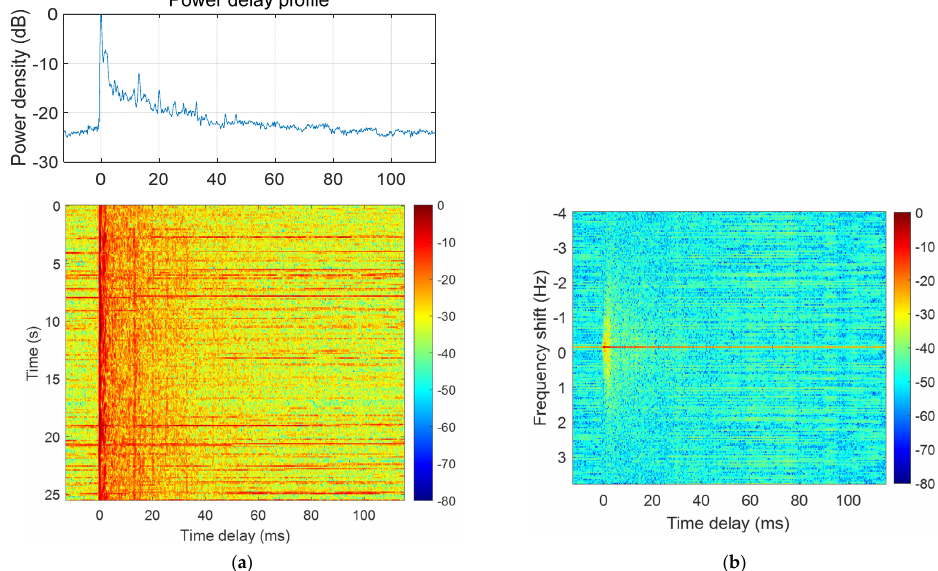
Figure 15. ( a ) Measured channel impulse response. ( upper panel ) A linear plot of the impulse ‐ response function, ( b ) Delay ‐ Doppler spread function